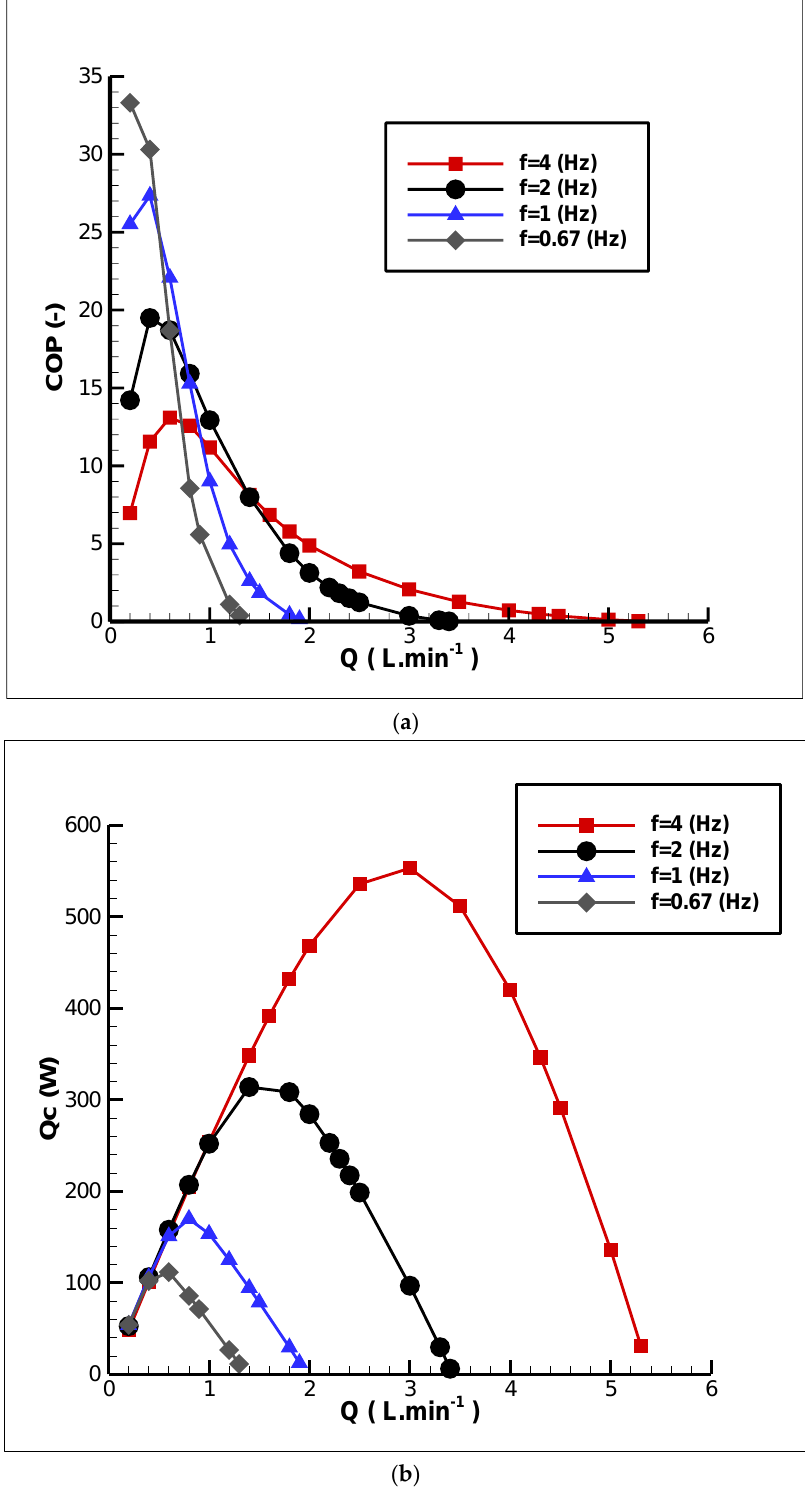
Figure 9. ( a ) the coefficient of performance and ( b ) refrigeration capacity based on the volumetric flow rate for a temperature span of 1 K at different frequencies.